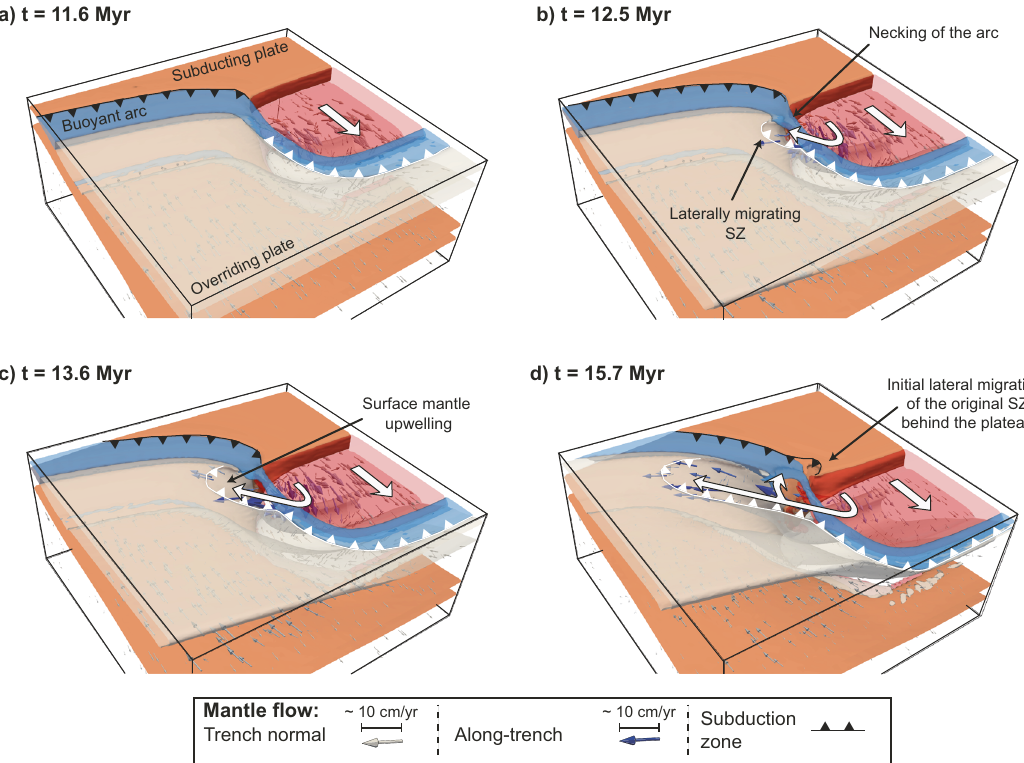
Fig. 2 Reference model post polarity reversal evolution lateral migration of the newly formed subduction zone. To better visualize the sub-lithospheric mantle fl ow in the area marked by a square in Fig. 1d, the plateau was made semi-transparent in the depicted evolutionary stages, which comprise: a Initial opposite verging double subduction system (same stage as in Fig. 1d). b Early lateral migration of the newly formed SZ, aided by mantle fl ow funnelling beneath the arc. The arc itself is strongly strained, showing signs of necking. c Evolving lateral migration with mantle upwelling. d Bifurcation of mantle fl ow enhances incipient propagation of the original subduction zone behind the oceanic plateau. This is similar to what has been previously described for plateau-continent collisions 27,28